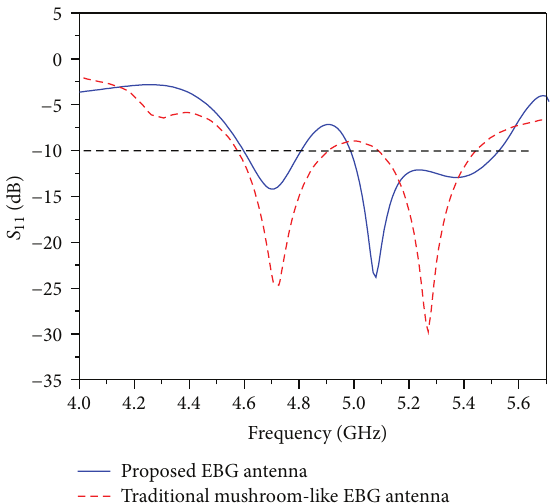
Figure 14: The 𝑆 11 parameters of the proposed EBG antenna and the traditional mushroom-like EBG